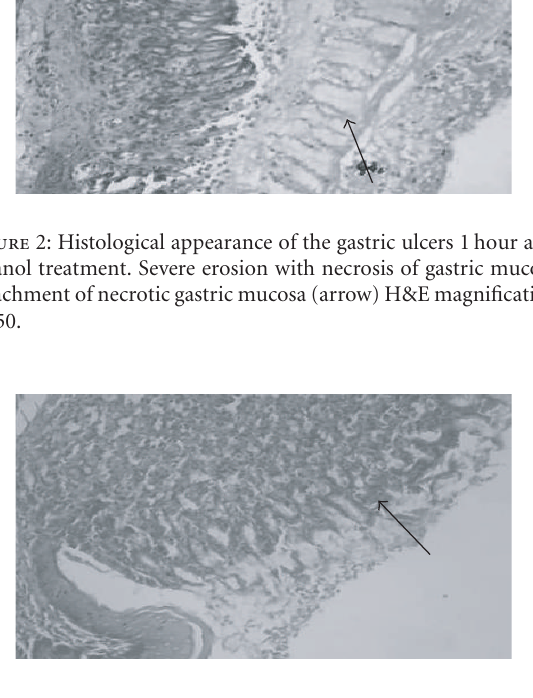
Figure 3: Rat pretreated with OSO, slight erosion of the gastric mu- cosa is observed. Arrow: H&E; magnification, X